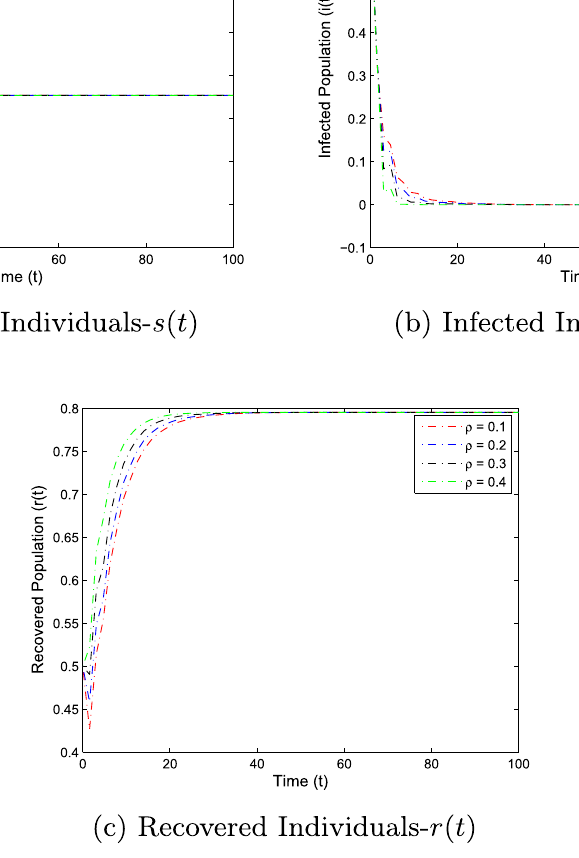
Figure 7. The graphs represent the temporal dynamics of the model against various values of white noise intensity in case of disease extinction, which reflects that there is no considerable effect of white noise intensity on the disease